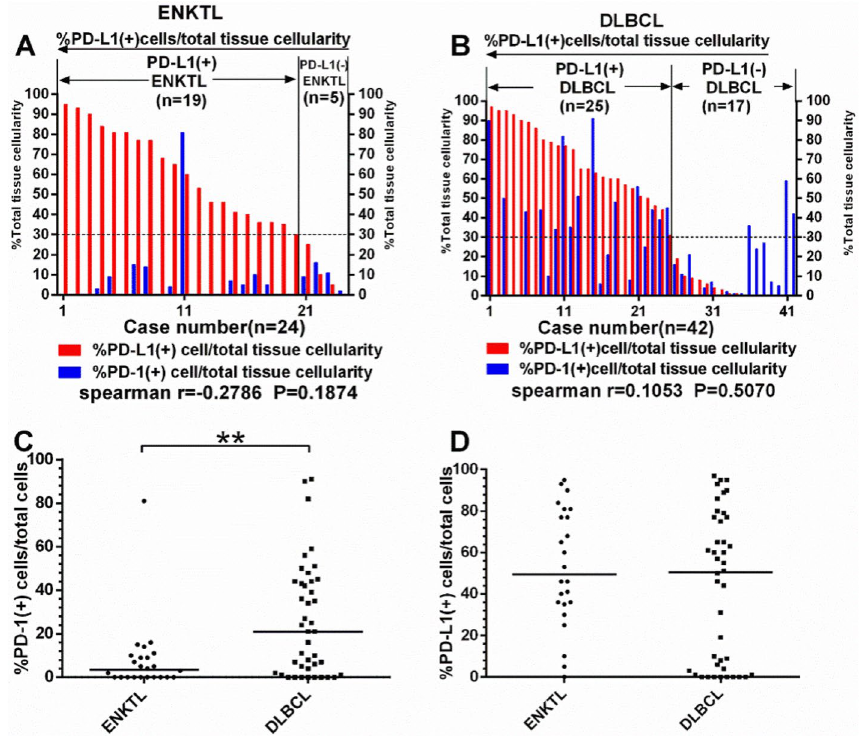
Figure 2. Details and correlation analysis of PD-1/PD-L1 expression in tumor tissues of ENKTL ( A ) and DLBCL ( B ) patients. No correlation was found between PD-1 and PD-L1 level from tumor tissues of ENKTL and DLBCL patients. Scatter plot of PD-1 ( C ) and PD-L1 ( D ) expression showed that PD-1 level in tumor tissues from ENKTL patients was lower than DLBCL.**P <